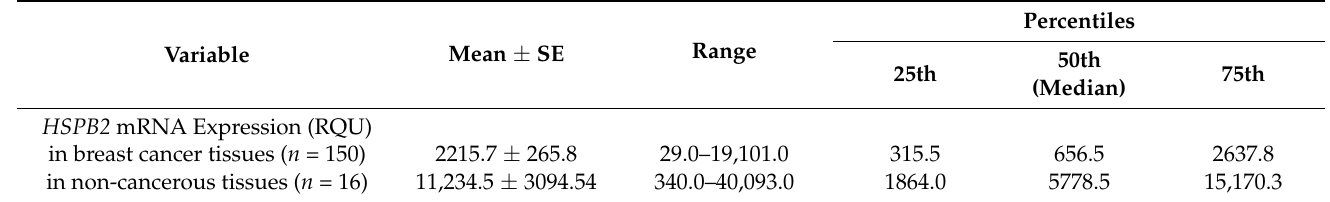
Table 2. Distributions of HSPB2 mRNA expression levels in cancerous and non-cancerous tissue samples.